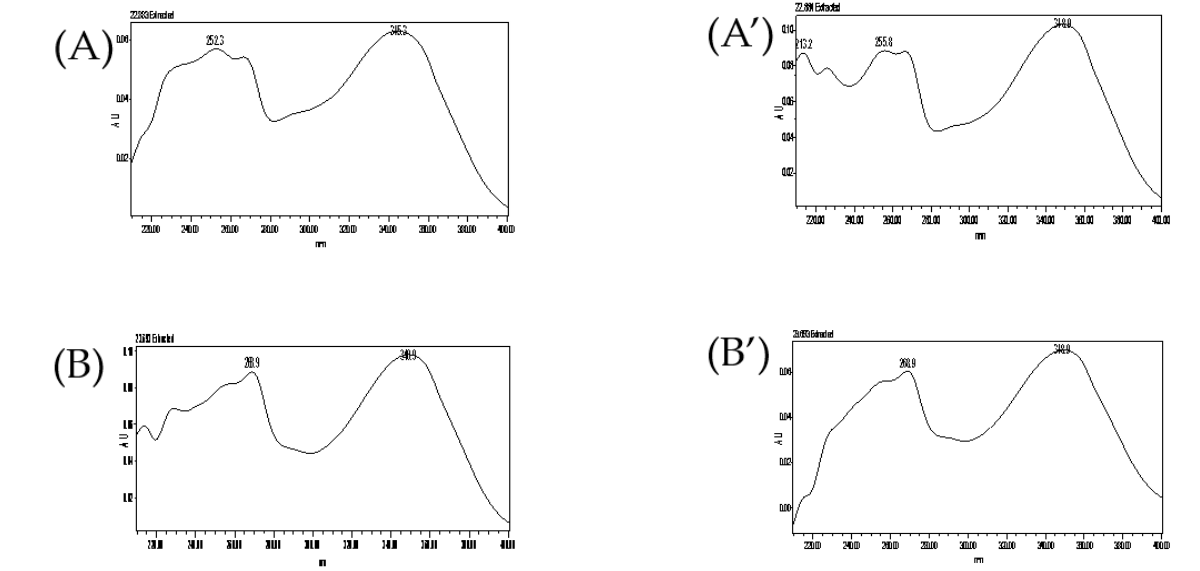
Figure 4. Photodiode array (PDA) spectral patterns were as follows: VB extract sample of ( A ) orientin and ( B ) isoorientin; standard solutions of ( A’ ) orientin and ( B’ ) isoorientin.